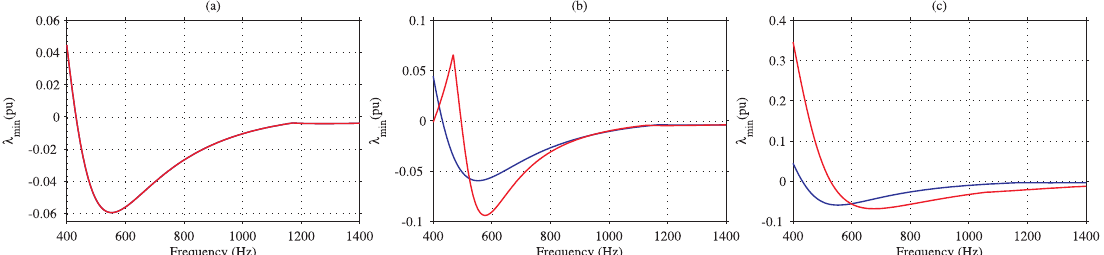
Figure 5. Frequency characteristics of the index λ min from 400–1400 Hz with variation in control parameters; ( a ) closed-loop bandwidth for the power controllers as 6 Hz (blue) and 3 Hz (red); ( b ) closed-loop bandwidth for the current controller as 300 Hz (blue) and 450 Hz (red); and ( c ) parameters of the virtual impedance as R v = R f , L v = L f (blue) and R v = 1.5 R f , L v = 1.5 L f